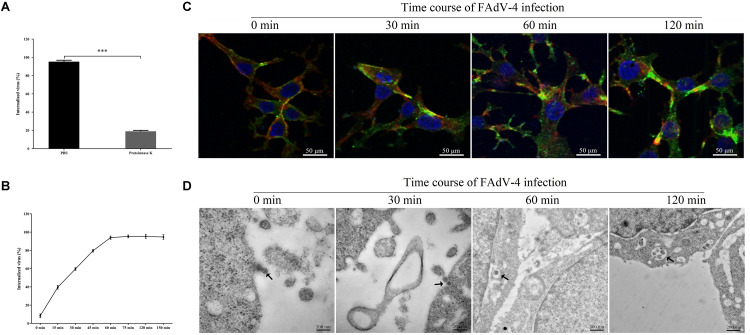
Kinetics of FAdV-4 internalization into leghorn male hepatocellular (LMH) cells. (A) The effectiveness of proteinase K treatment; results are shown as a percentage of FAdV-4 copy number of the proteinase K-treated group and the phosphate-buffered saline (PBS)-treated group compared with controls and are presented as the mean ± SD of three independent experiments; ***P < 0.001. (B) The rate of FAdV-4 internalization into LMH cells; results are shown as a percentage of internalized viruses compared with controls in which PBS was substituted for proteinase K. (C) Confocal laser scanning microscopy (CLSM) analysis of actin filaments (red), viral particles (green), and cell nuclei (blue) in FAdV-4-infected LMH cells at the indicated time points post-infection. (D) Microscopic analysis of FAdV-4 entry into LMH cells at specified time points after infection. Transmission electron microscopy image showing the localization of virions. The virions are indicated by black arrows.